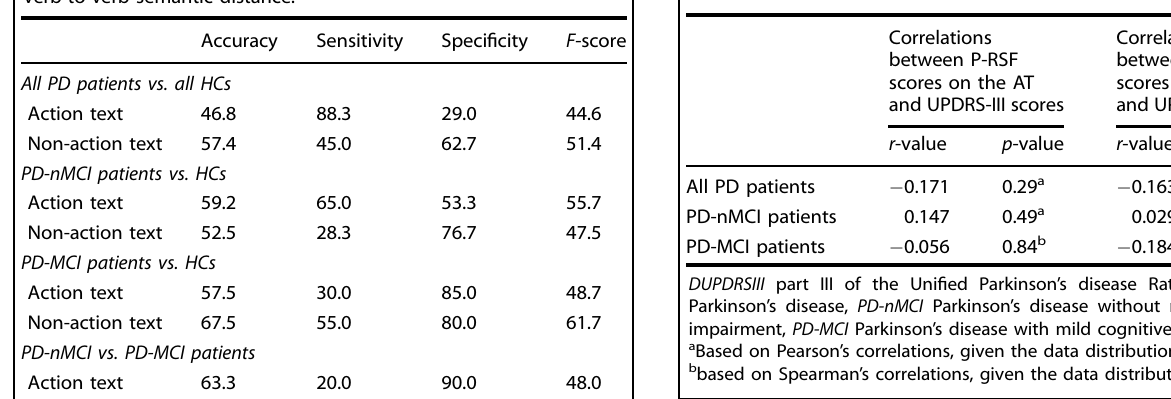
Table 4. Exploratory correlations between P-RSF scores and UPDRS-III scores.